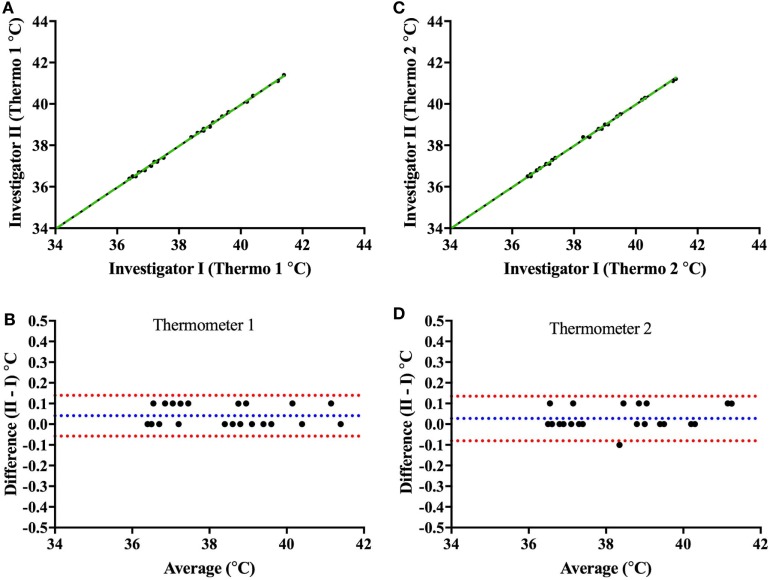
Interinvestigator-associated bias for each Hg thermometer readings. Top panels show plots comparing readings from both investigators (I vs. II) for Hg thermometer 1 (A) and Hg thermometer 2 (C) across the range of 35–40°C; the dashed green lines being the lines of identity. To note that the two investigators I and II (authors CM and JC, respectively) read the thermometer temperature within a few seconds of each other—and values recorded blinded from each other. Bottom panels show Bland–Altman plots of the difference vs. the average of readings comparing investigators I and II for Hg thermometer 1 (B) and Hg thermometer 2 (D). Blue and red dashed lines indicate the mean bias and limits of agreement, respectively.